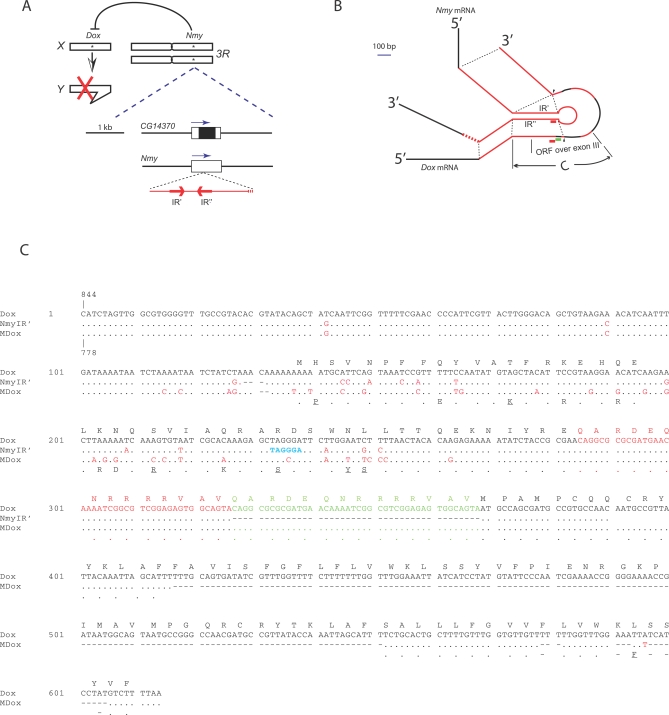
Homology Among Dox, Mdox, and Nmy
(A) Schematic of the Winters sex-ratio system. An autosomal suppressor, Nmy, is apparently a new gene created by a 2,041-bp insertion (red) in the gene CG14370. The insert contains a pair of almost perfect IRs of 345 bp (red arrows, IR' and IR'') and they are required for the suppression of Dox. Nmy originated through a retrotransposition event from Dox, because all of the 2,041 bp consists of paralogous sequence from cDNA of Dox (red line) and the 5′ region upstream of Dox transcription (dashed red line) [24].(B) A detailed comparison between transcripts of Dox and Nmy. Paralogous sequences are in red. The 5′ and 3′ ends of Nmy (black line) are from CG14370. IR' might have duplicated from IR” after the retroposition [24], while some sequences (black between the two small arrow heads) in Dox no longer have paralogs in Nmy. The 42-bp elements are shown in red and green color, as in Figure 4. The dox allele has lost one of the 42-bp elements in the transcript. A dsRNA stem is presumably formed between the two IR's. The critical region marked as “C” is detailed in (C).(C) The critical region “C” with a base-by-base comparison among Dox, Nmy, and MDox. Identical bases or amino acids are represented by a period, and deletion by a dash, and divergent bases are in red. This region starts at position 844 (778) of the Dox (MDox) transcript and the beginning of IR', respectively. IR' and IR'' are identical except for a 6-bp (TAGGGA) deletion in IR' (cyan). The two tandem 42-bp elements are also shown in red and green, respectively on the Dox sequence. The amino acids encoded by the ORF in this region are shown in the top (Dox) and bottom lines (MDox), respectively. These two ORFs have an amino acid identity of 94/107 (88%) and similarity of 100/107 (93%) (underlined).